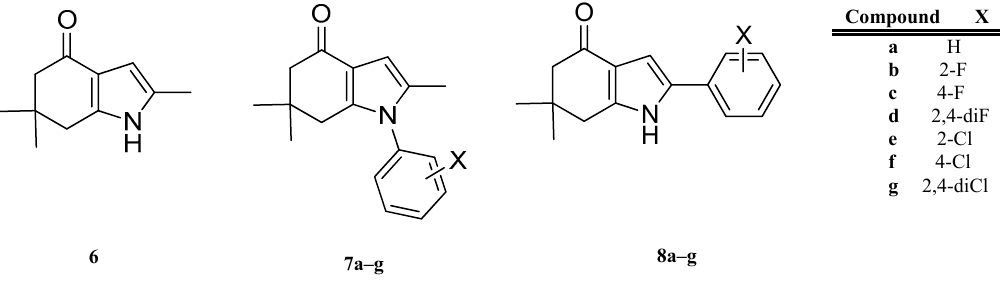
Figure 1. Indol-4-ones 6 , 7a – g and 8a – g designed, synthetized and tested by Gonzalez et al . [6] .